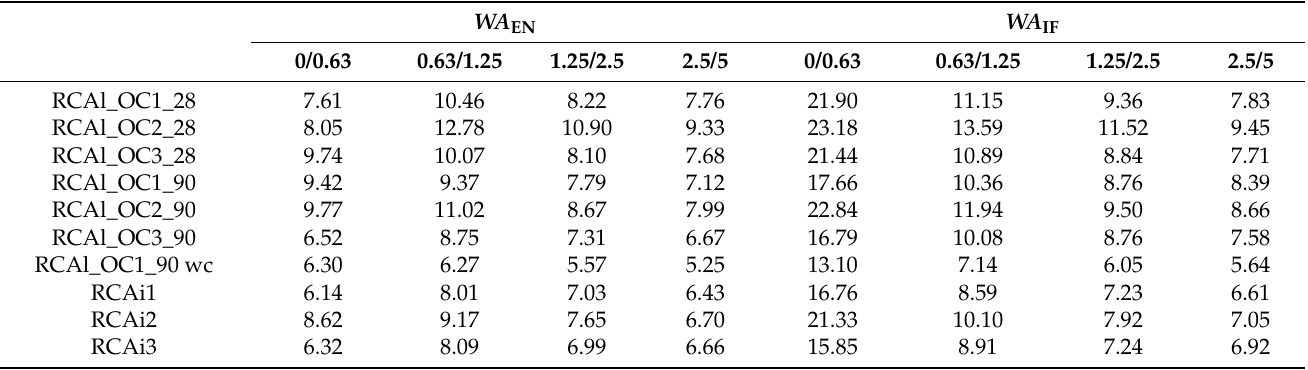
Table 9. Water absorption of all fractions (in mm) of studied RCA determined by standard EN ( WA EN ) and IFSTTAR ( WA IF ) methods (%). WA